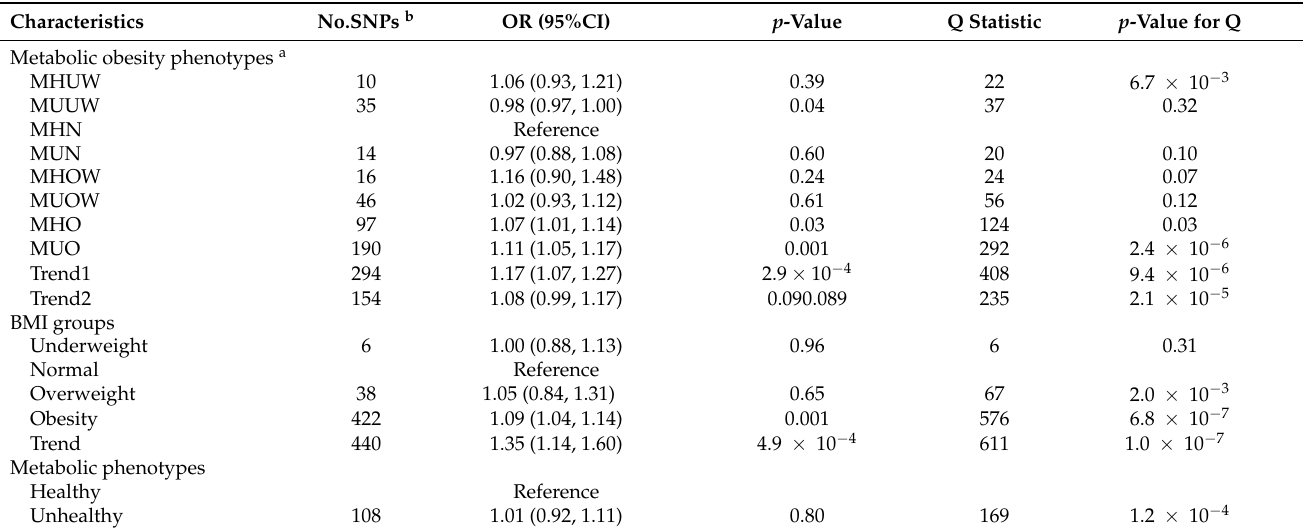
Table 3. Two-sample MR estimates for the relationship between metabolic obesity phenotypes and incident